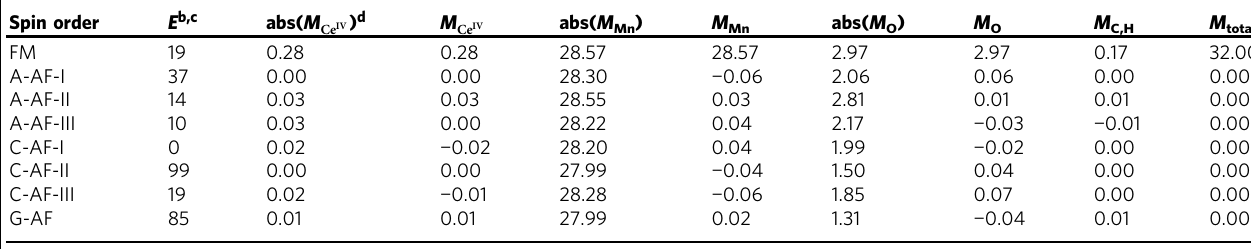
Table 1 Total energy ( E ) and atomically resolved magnetic moments ( M a ) due to valence electrons for different sites of Ce 3 Mn 8 in different spin-ordered states Spin